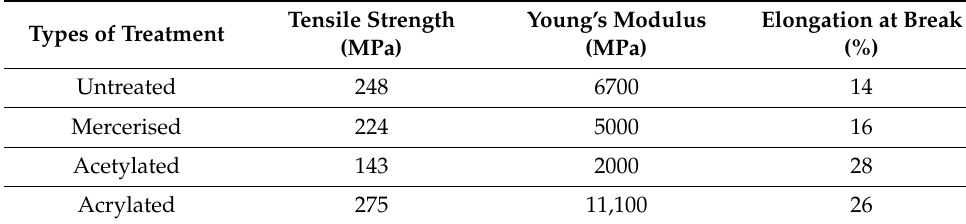
Table 12. Mechanical performance of untreated and treated oil palm fibers.